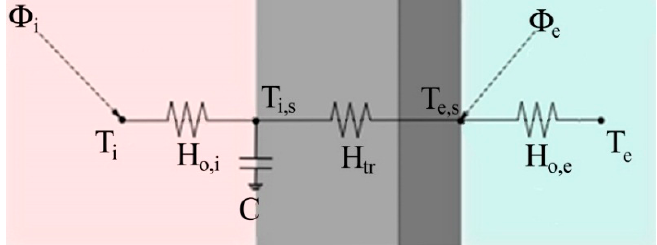
Figure 5. A 3 Resistance 1 Capacitance (3R1C) module.